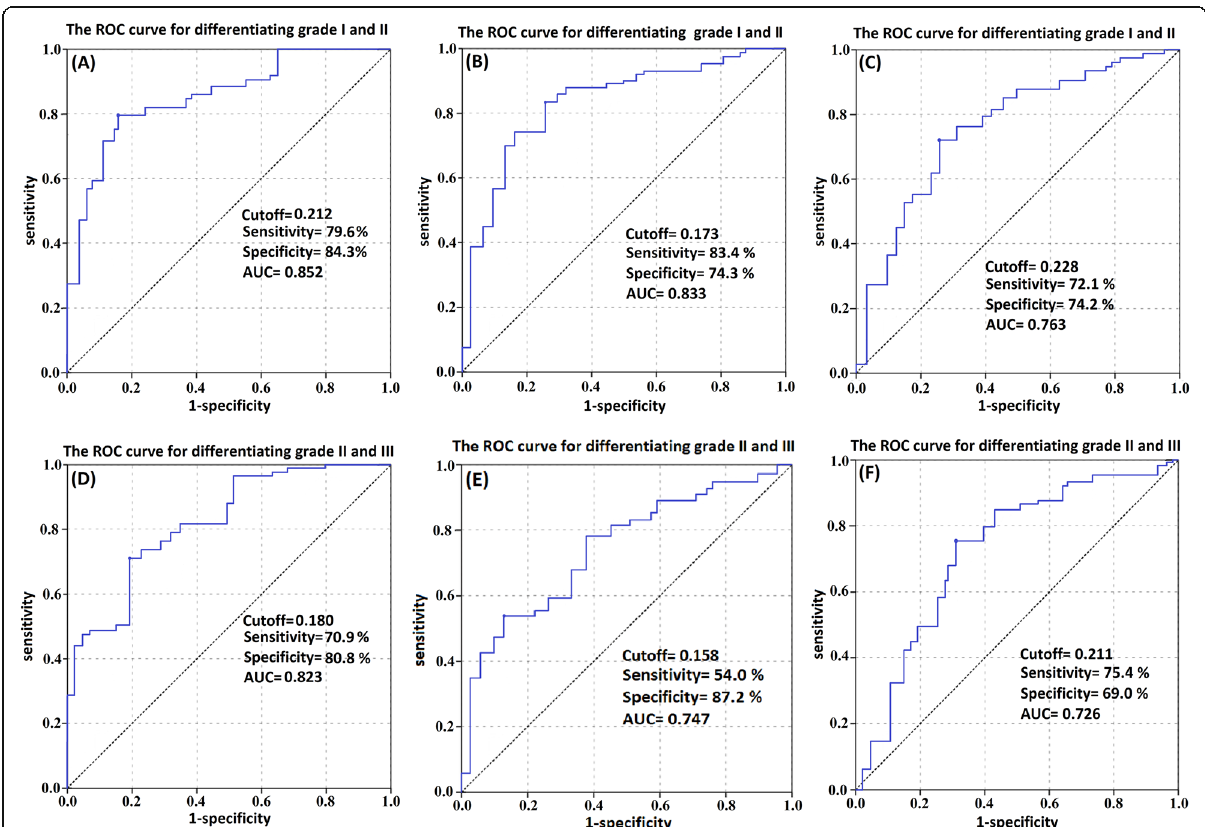
Fig. 4 ROC curves including the model cutoff values, sensitivity, specificity, and AUC for differentiating the tumor grades (I from II; and II from III). A ROC curve obtained from the model fitted to ADC histogram parameters for differentiating grade I and II meningioma tumors. B ROC curve obtained from the model fitted to post-contrast T1WI histogram parameters for differentiating grades I and II meningioma tumors. C ROC curve obtained from the model fitted to T2WI-FLAIR histogram parameters for differentiating grades I and II meningioma tumors. D ROC curve obtained from the model fitted to ADC histogram parameters for differentiating grades II and III meningioma tumors. E ROC curve obtained from the model fitted to post-contrast T1WI histogram parameters for differentiating grades II and III meningioma tumors. F ROC curve obtained from the model fitted to T2WI-FLAIR histogram parameters for differentiating grades II and III meningioma